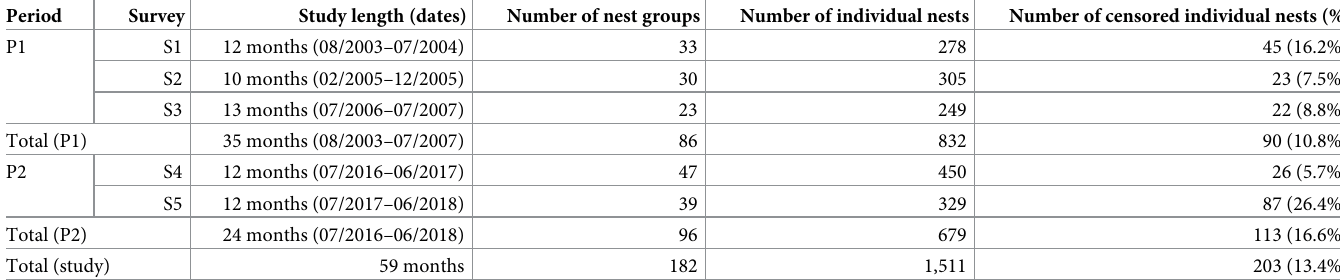
Table 2. Period- and survey-specific